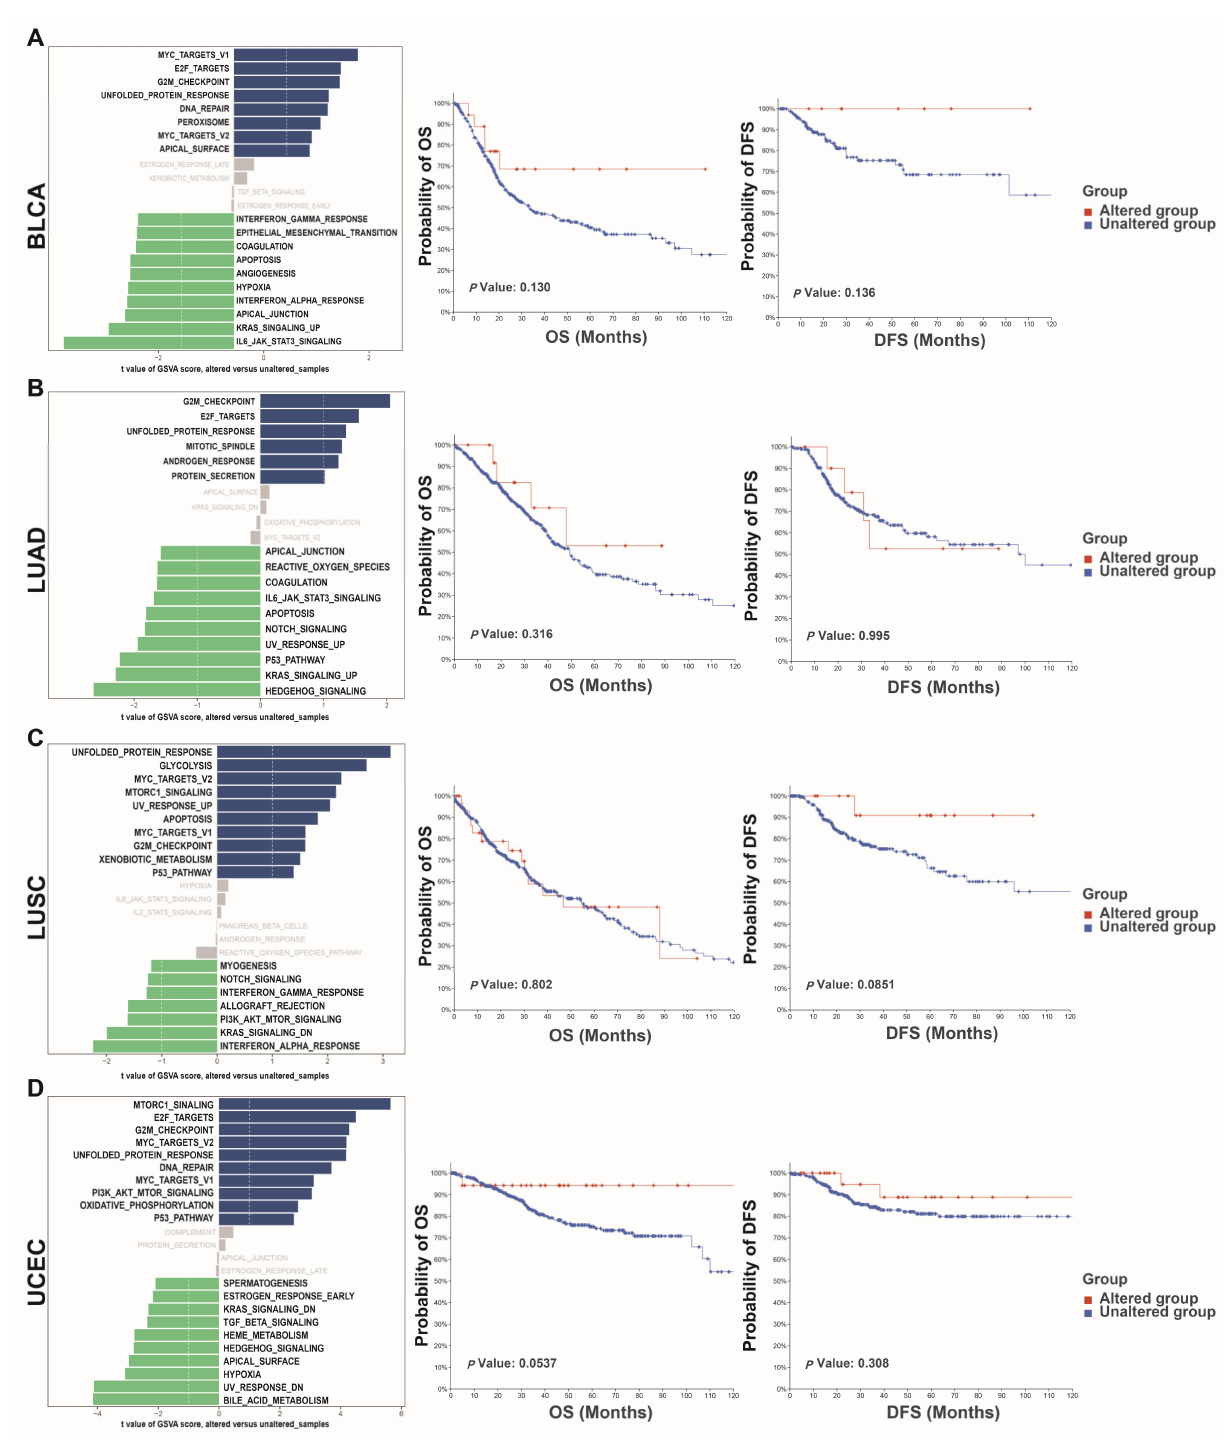
Figure 5. Potential role of altered NEIL3 in cancers. ( A – D ) GSVA of enriched pathways and OS anal- ysis of the NEIL3-altered and -unaltered groups in BLCA ( A ), LUAD ( B ), LUSC ( C ), and UCEC ( D